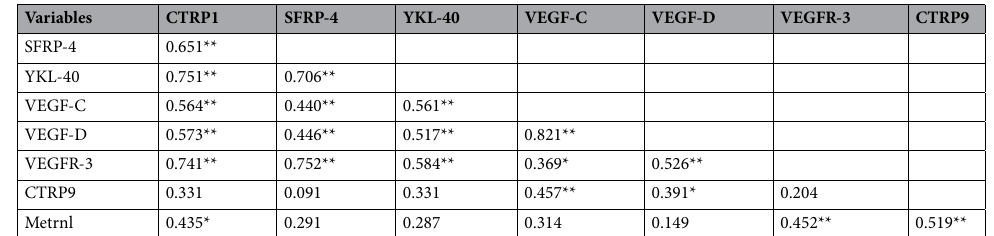
Table 5. The correlation matrix of cytoadipokines mRNA expression in EAT. CTRP, complement-Clq TNF- related protein; SFRP4, secreted frizzled-related protein 4; YKL-40, Chitinase-3-like protein 1; VEGF, vascular endothelial growth factor; VEGFR-3, vascular endothelial growth factor receptor 3; Metrnl, Meteorin-like. *P < 0.05, **P < 0.01.